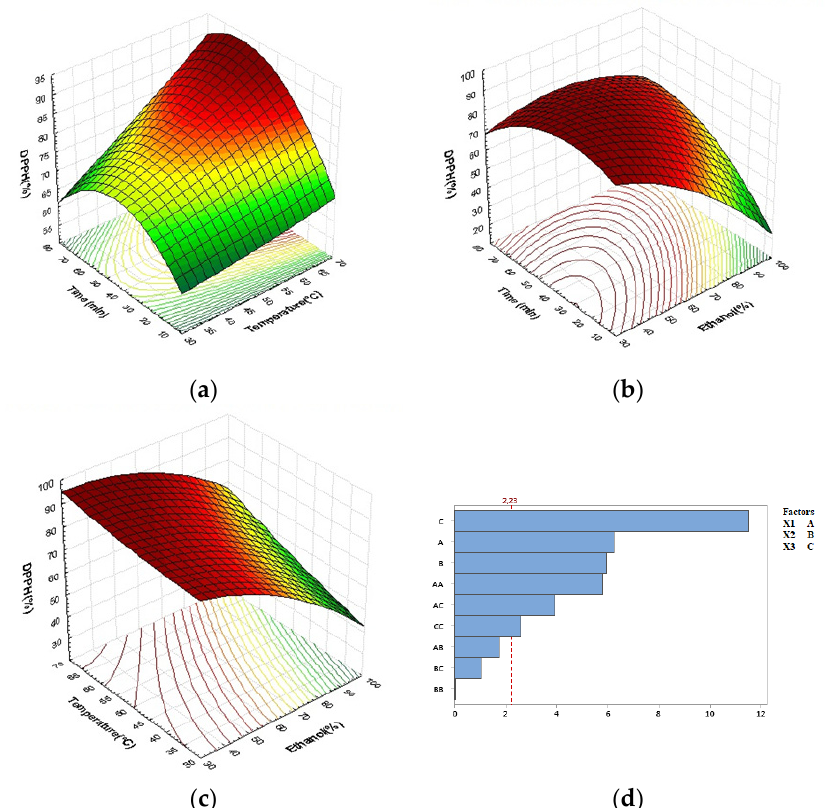
Figure 5. Response surface plots indicating combined effects of UAE variables on DPPH: ( a ) time and temperature, ( b ) time and ethanol concentration, ( c ) temperature and ethanol concentration, ( d ) Pareto chart ( α = 0.05). Table 4. ANOVA for evaluation of measurement of